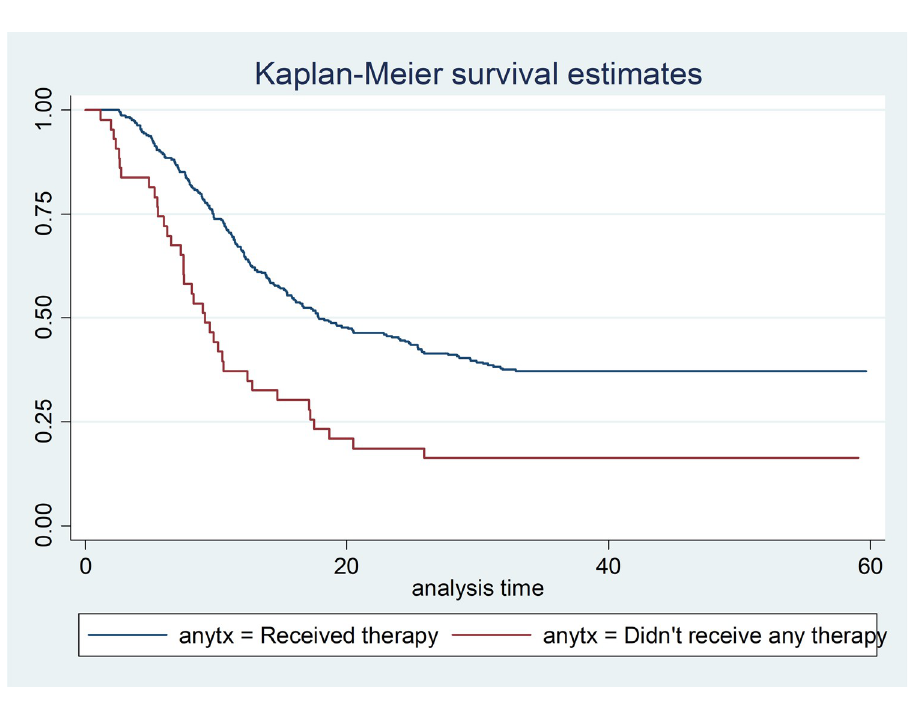
https://doi.org/10.1371/journal.pone.0264369.g002